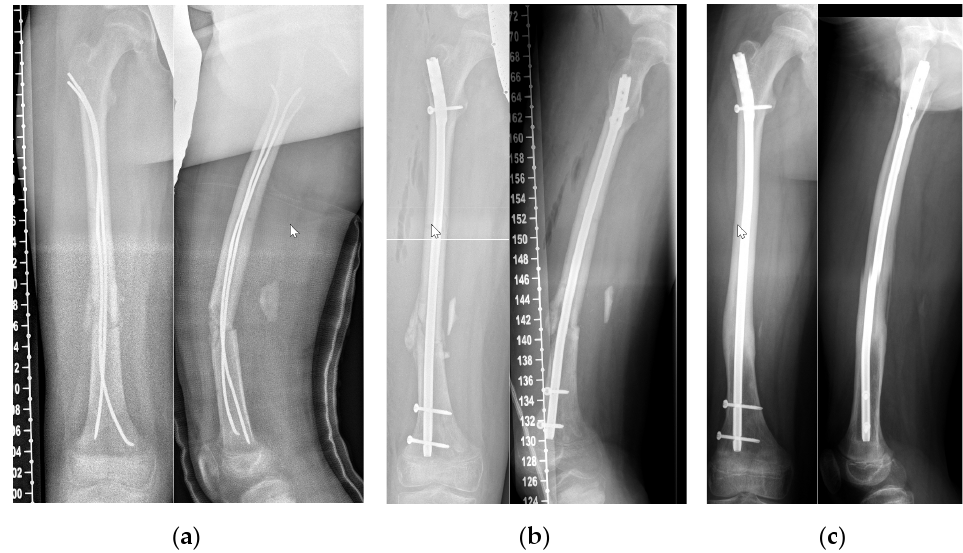
Figure 3. ( a ) Three days after anterograde ESIN for a femoral fracture. Due to additional injuries an anterograde approach was used. For this reason, it was not possible to achieve as much tension at the level of the fracture as we would have desired. ( b ) Same patient as in Figure 3a, six weeks after the anterograde ESIN fixation we revised to an ALFN. ( c ) Now eight months after revision to ALFN, with union in correct position.